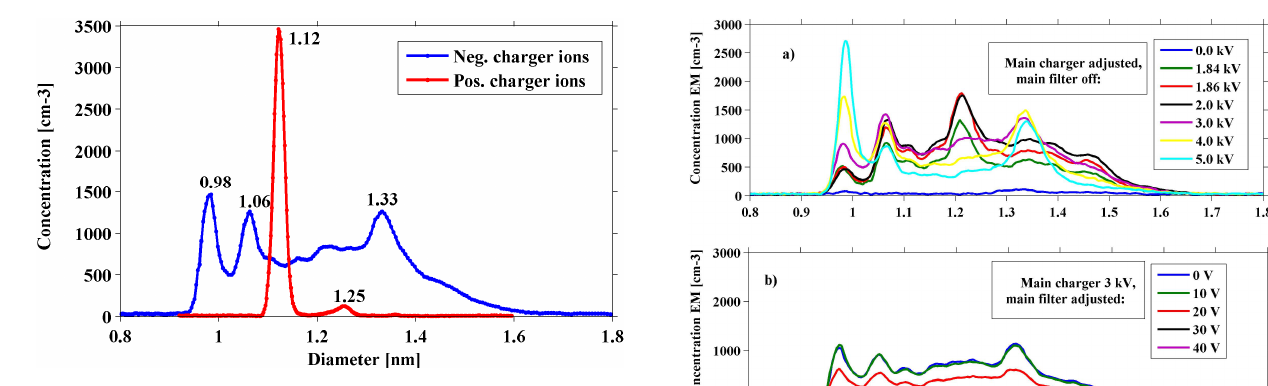
Figure 3. The median mobility diameter distribution of negative and positive ions produced 503 Fig. 3. The median mobility diameter distribution of negative and by corona discharge when ±3 kV was applied to the corona-needle and the carrier gas was 504 positive ions produced by corona discharge when ± 3kV was ap- filtered compressed air. 505 plied to the corona-needle and the carrier gas was filtered com- pressed air. Fig. 4. Median size distribution of negative corona-generated ions